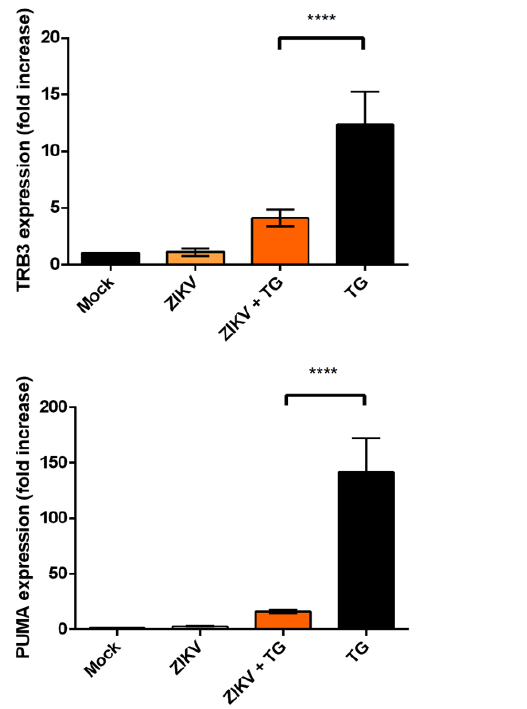
Figure 5. Transcriptional activity of CHOP-dependent genes. qRT-PCR analysis of TRB3 ( a ), BIM ( b ), PUMA ( c ) and NOXA ( d ) mRNAs were performed in A549 cells. The cells were harvested 24 h after being or not infected with ZIKV at MOI = 5 or treated 4 h with TG 20 h.p.i with ZIKV. Our positive control cells were treated with TG for 4 h. Data were presented as mean SEM ( n = 3). **** p < 0.0001, ** p < 0.01 vs. mock.